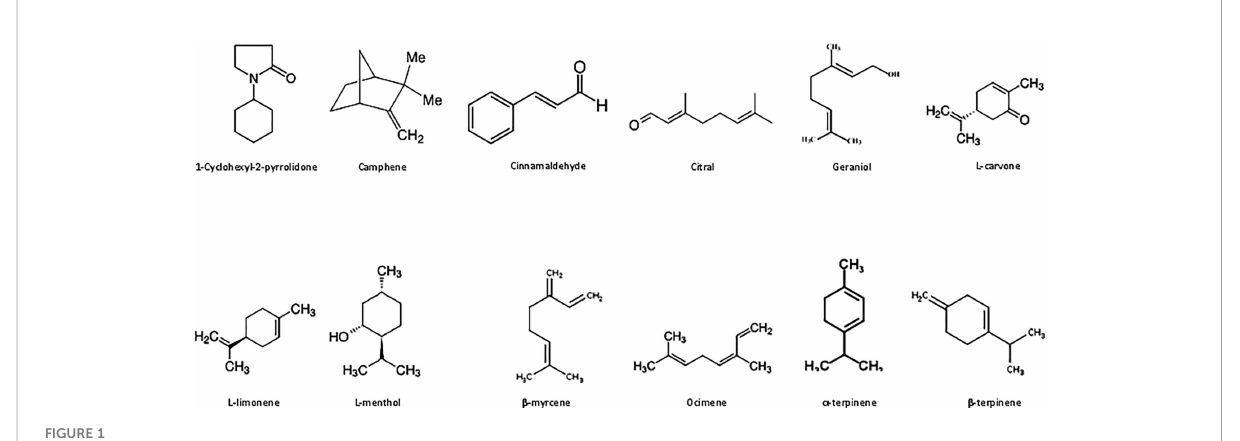
FIGURE 1 Some active pure compounds from essential